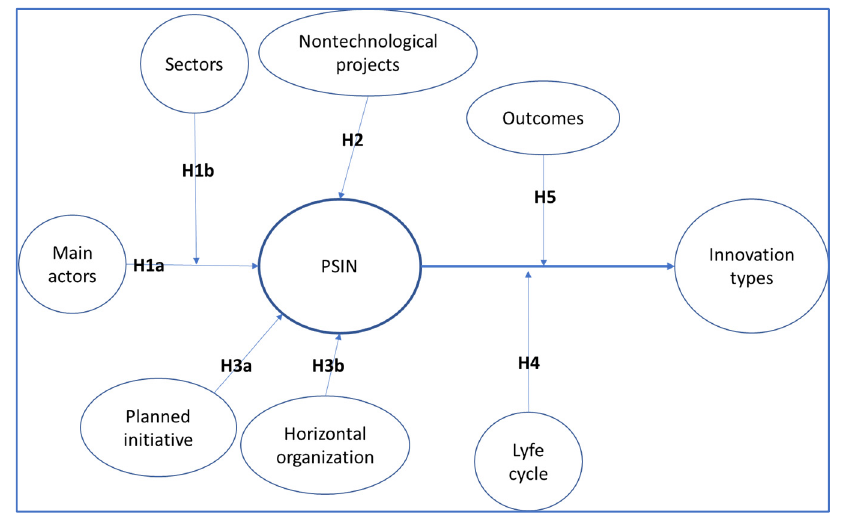
Figure 1. Research model.